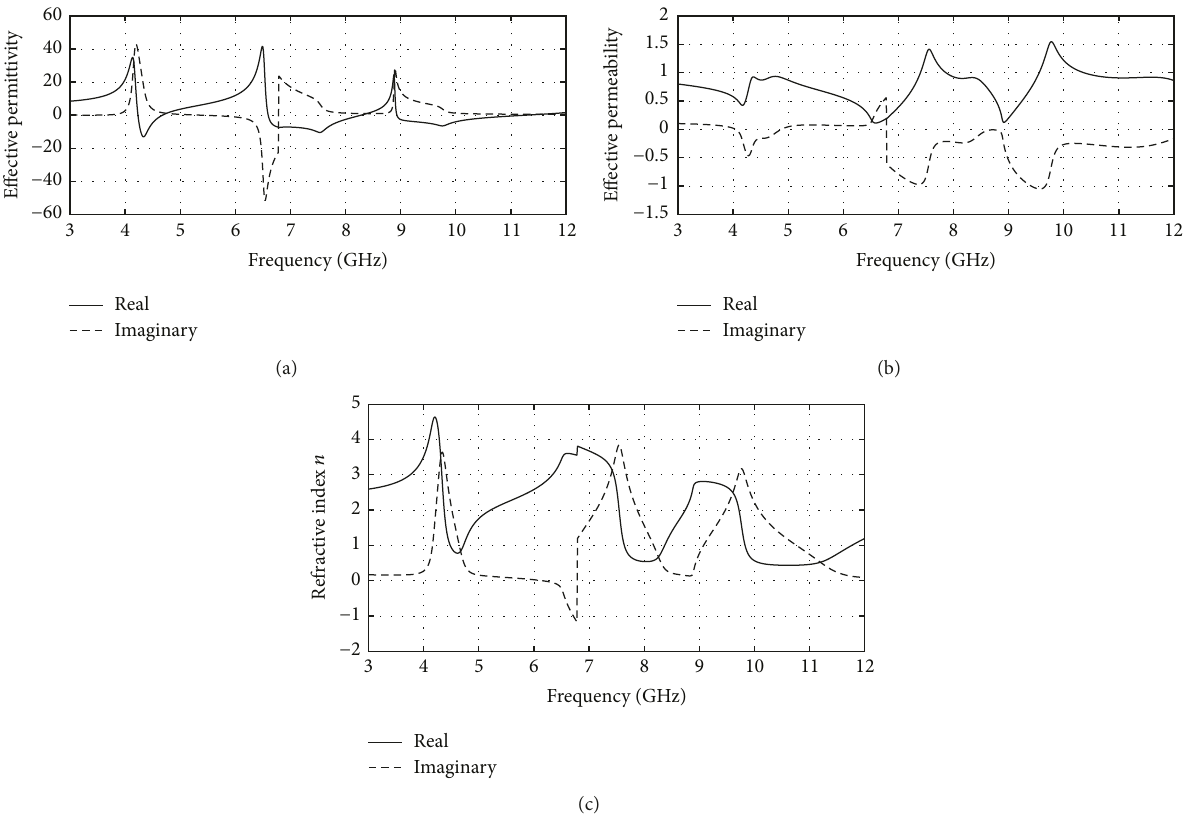
Figure 4: Computed effective medium parameters for the proposed triple-band electric metamaterial resonator (TBEMR): (a) permittivity, (b) permeability, and (c) refractive index, respectively. The solid lines represent the real part while dashed line represents imaginary